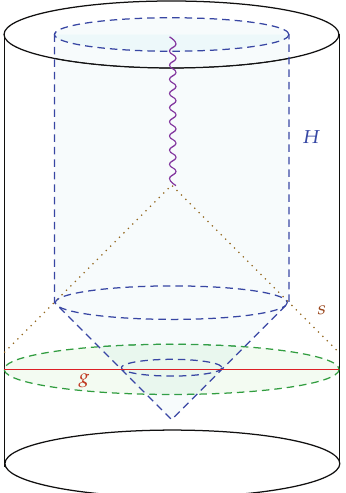
Figure 9: Gedanken experiment of (cid:5) 184 (cid:6) demonstrating that spacelike geodesics g (cid:3) or minimal surfaces (cid:4) which are anchored on the AdS boundary can pass through an event horizon H of a dynamically evolving spacetime, here exemplified by a null shell s collapsing to form the black hole (cid:3) shaded blue (cid:4) . The corresponding Penrose diagram is sketched in Figure